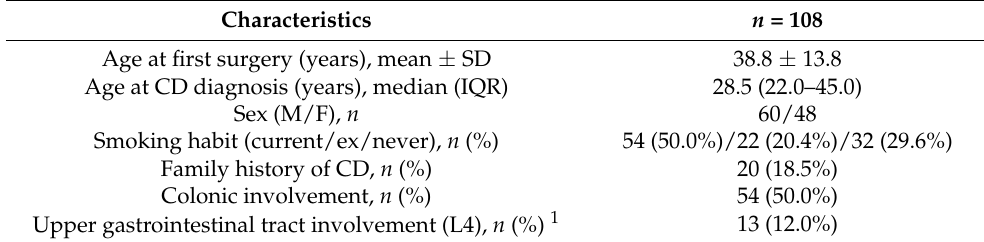
Table 1. Baseline characteristics of the patients included in the study.